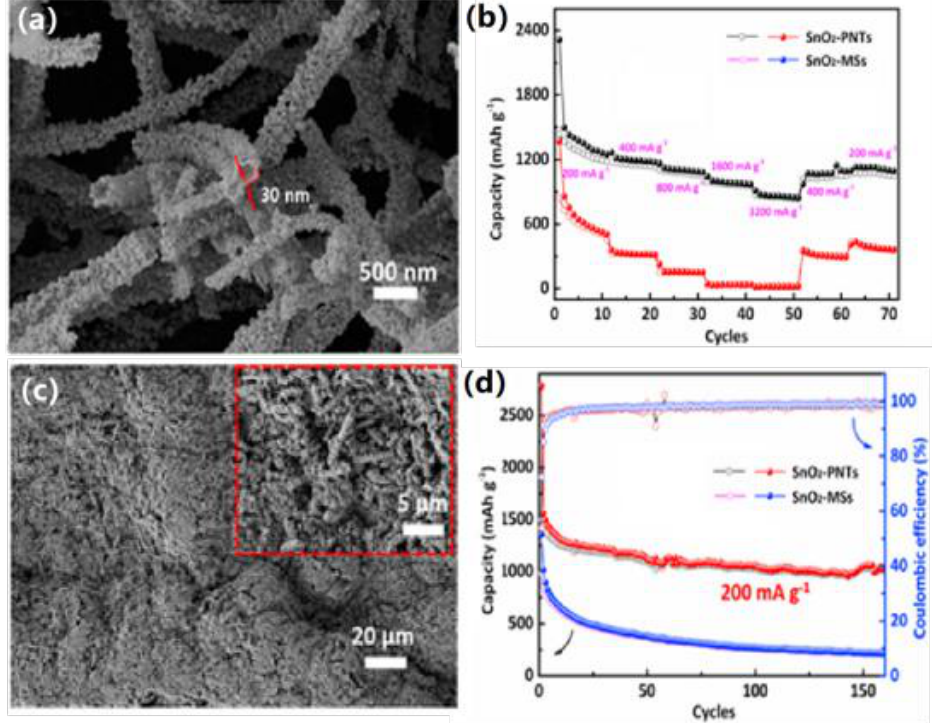
Figure 9. ( a ) SEM image of SnO 2 porous nanotubes (SnO 2 -PNTs). ( b ) Rate performances of SnO 2 - PNTs and commercial SnO 2 microspheres (SnO 2 -MSs). ( c ) SEM image of SnO 2 -PNTs after 100 cycles; the inset shows the partially enlarged view. ( d ) Cycling performances of SnO 2 -PNTs and SnO 2 -MSs at a current density of 200 mA/g. Copyright © 2008 American Chemical Society.